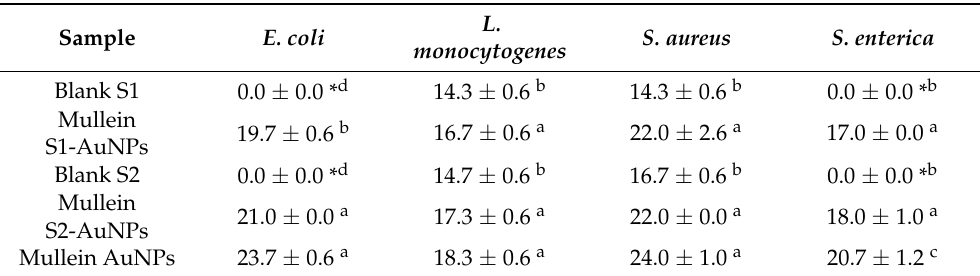
Table 2. Antibacterial activity of silica–gold nanoparticles with different pathogenic microorganisms, inhibition zone in mm.